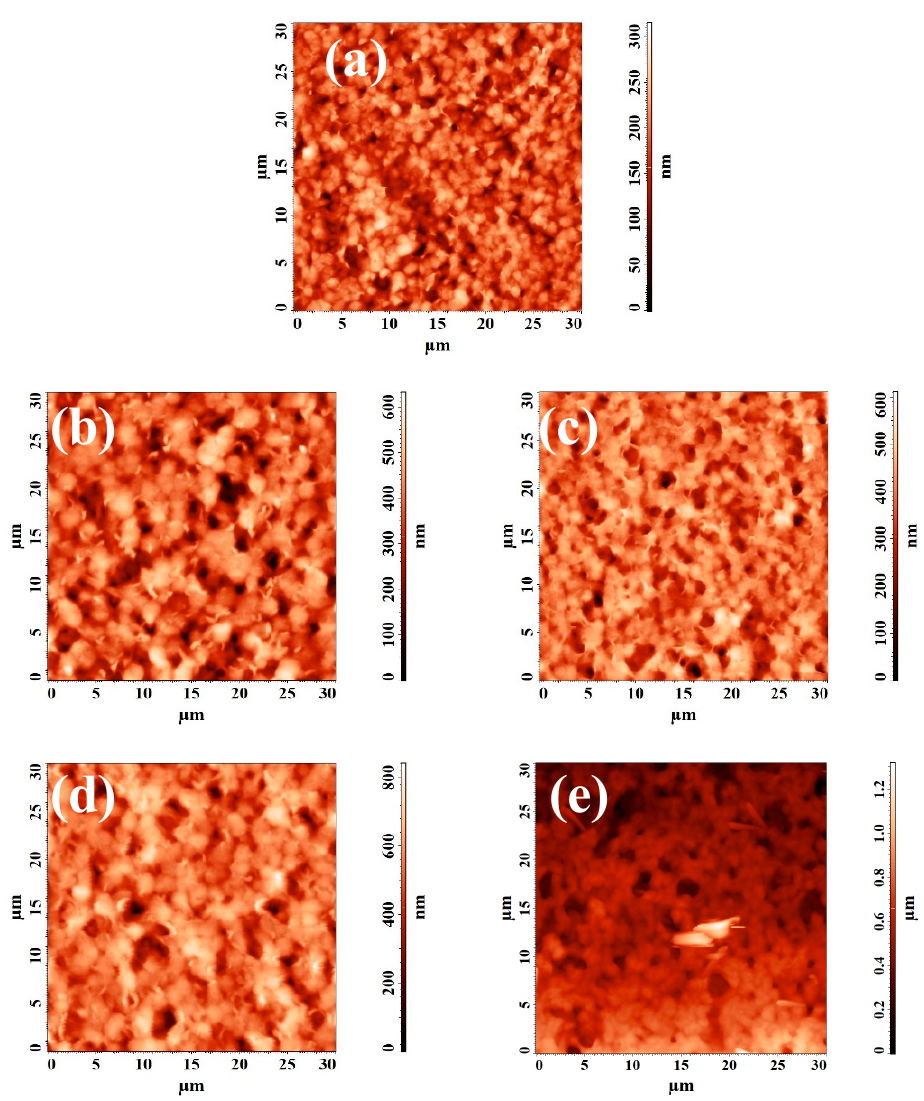
Figure 10. AFM images of the developed dense membranes: ( a ) PVDF dense , ( b ) PVDF+TiO 2 (0.5%) dense , ( c ) PVDF+GO-TiO 2 (0.5%) dense , ( d ) PVDF+MWCNT/TiO 2 (0.5%) dense , and ( e ) PVDF+Ag-TiO 2 (0.5%) dense . Based on the obtained AFM images, the characteristics of the membrane surface roughness (root-mean-squared (Rq) and average roughness (Ra)) were calculated and pre- sented in Table 3. Table 3. Roughness parameters of dense membranes based on PVDF and its composites with nano- particles.